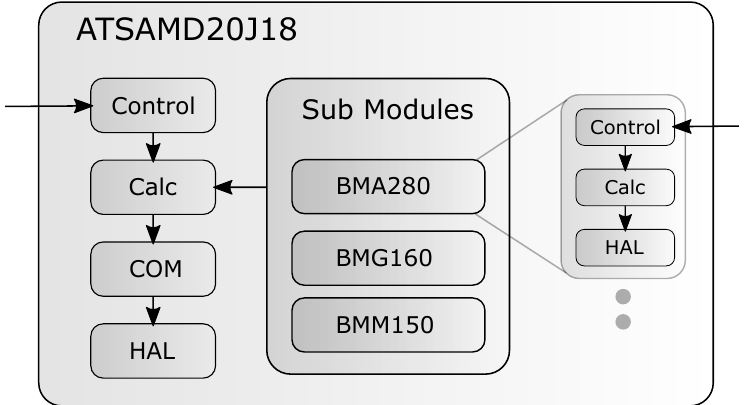
Figure 2. Specific structure of the sensor power